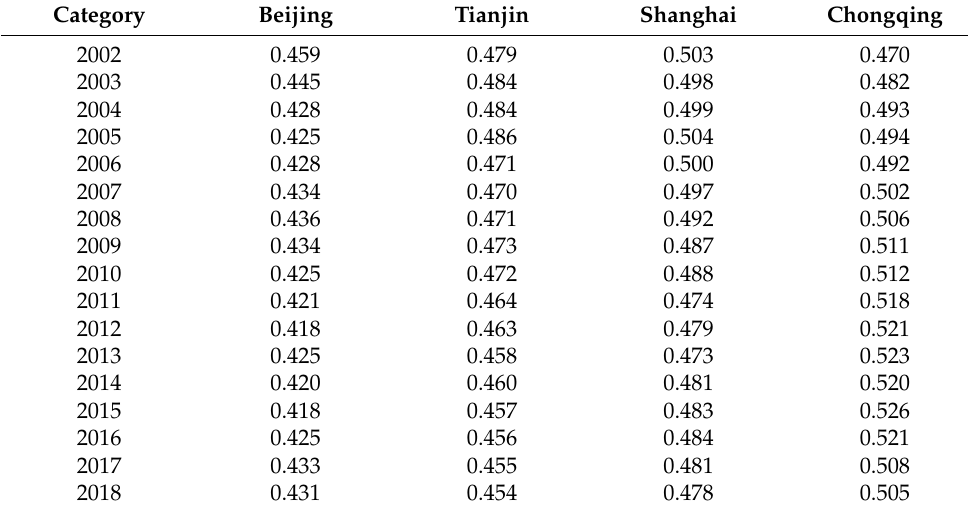
Table A4. Scores in response resilience levels from 2002 to 2018.